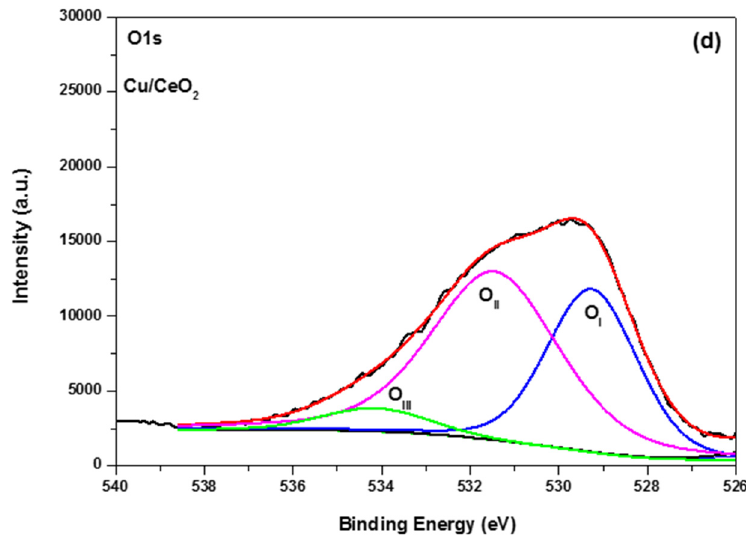
Figure 4. O1s spectra of Fe ( a ); Co ( b ); Ni ( c ) and Cu ( d ) catalysts supported on CeO 2 .